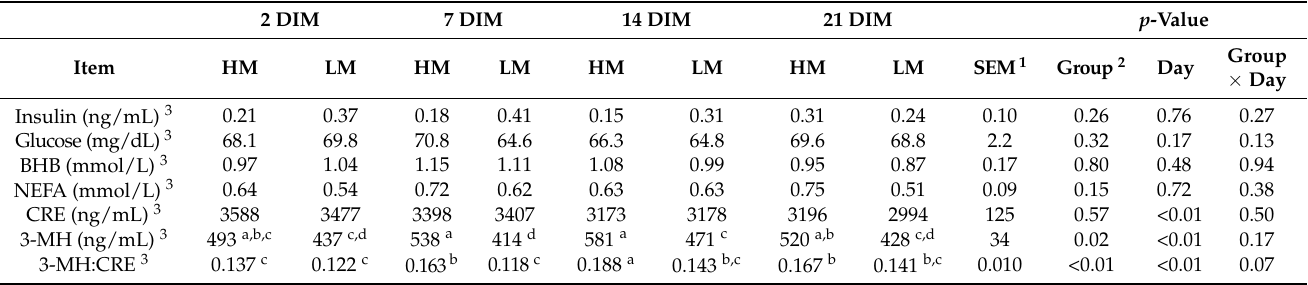
Table 4. Effect of high-muscle (HM; n = 20) and low-muscle (LM; n = 21) longissimus dorsi thickness (LDT) at 35 d before expected calving (BEC) on postpartum energy-related metabolites and hormone of insulin, glucose, β -hydroxybutyrate (BHB), non-esterified fatty acids (NEFA), creatinine (CRE), and 3-methyl histidine (3-MH). 2 DIM 7 DIM 14 DIM 21 DIM p -Value